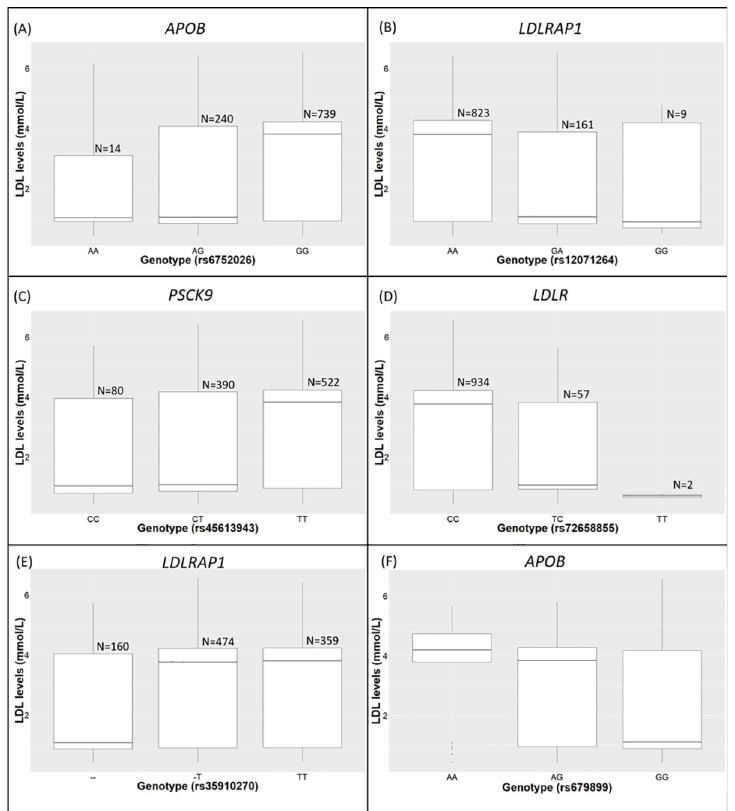
Fig 2. Genotypes relative to LDL-cholesterol distribution for 6 variants significantly associated with LDL- cholesterol levels after logistic regression. The 993 AWI-Gen individuals with low and high LDL-cholesterol are included in the plots. A-D: APOB rs6752026, LDLRAP1 rs12071264, PCSK9 rs45613943 and LDLR rs72658855 show how LDL-cholesterol levels decrease with presence of the minor allele. E: LDLRAP1 shows how LDL-cholesterol levels decrease only when both minor alleles are present (deletion). F: APOB rs679899 shows an increase of LDL-cholesterol levels with the presence of the minor